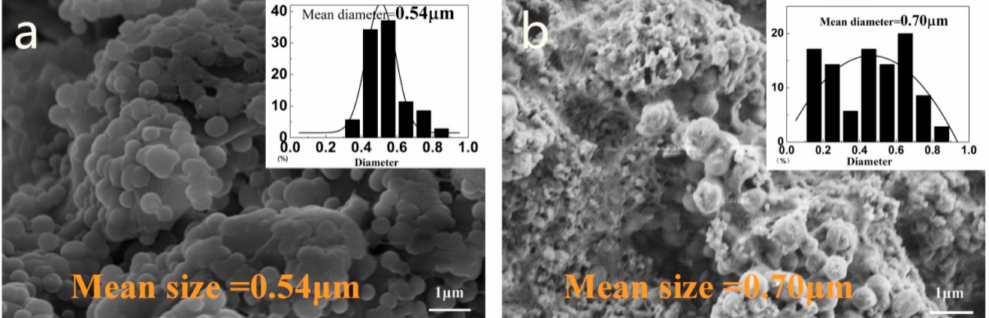
Figure 4. SEM Morphology of EDA-Polyurea microcapsules. ( a ) microcapsules with a mean size of 0.54 µ m ( b ) microcapsules have regular spherical shapes with a mean size of 0.70 µ